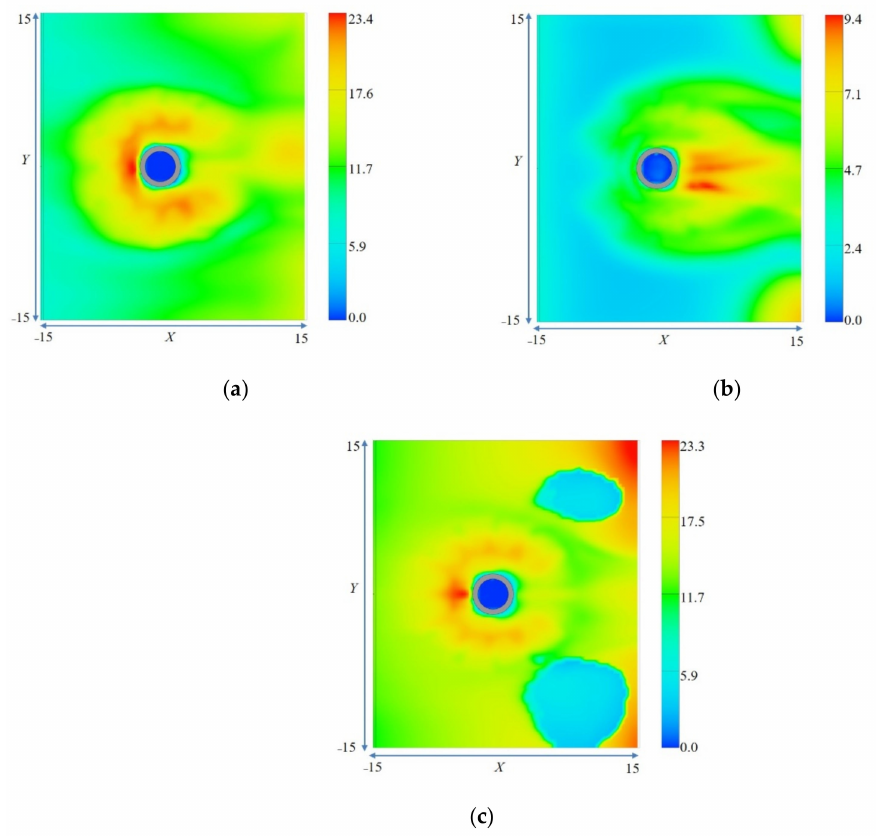
Figure 12. Turbulence intensity: ( a ) Turbulence intensity of horseshoe vortex; ( b ) Turbulence intensity of wake vortex; ( c ) Turbulence intensity of accretion